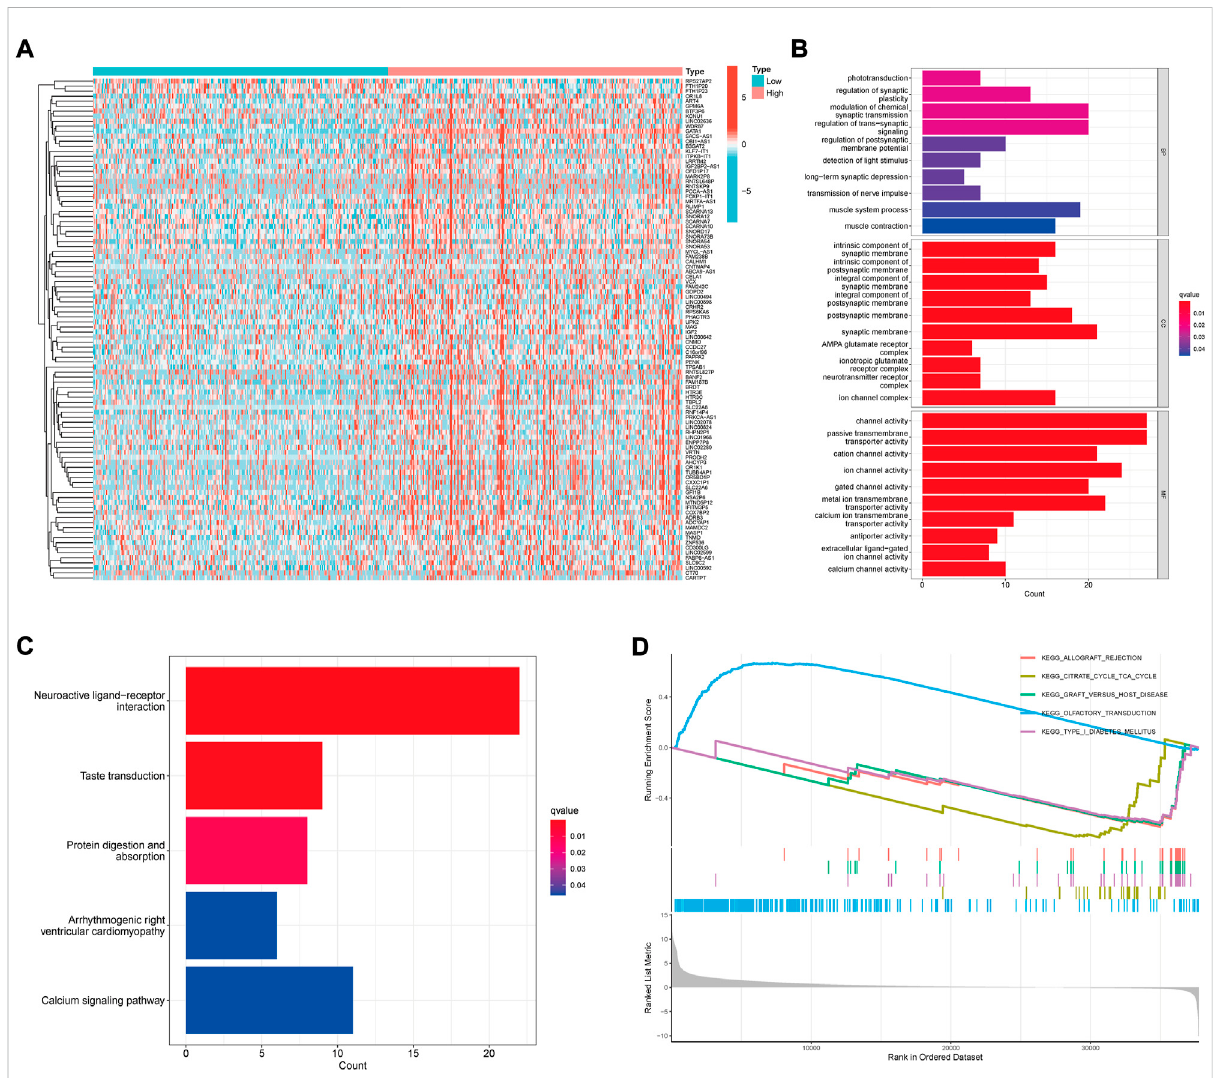
FIGURE 5 Functional analysis of differential gene enrichment in high and low expression groups. (A) Heat map of differential genes in high and low expression groups; (B) Functional analysis of GO enrichment; (C) Functional analysis of KGGG enrichment; (D) Functional analysis of GSEA